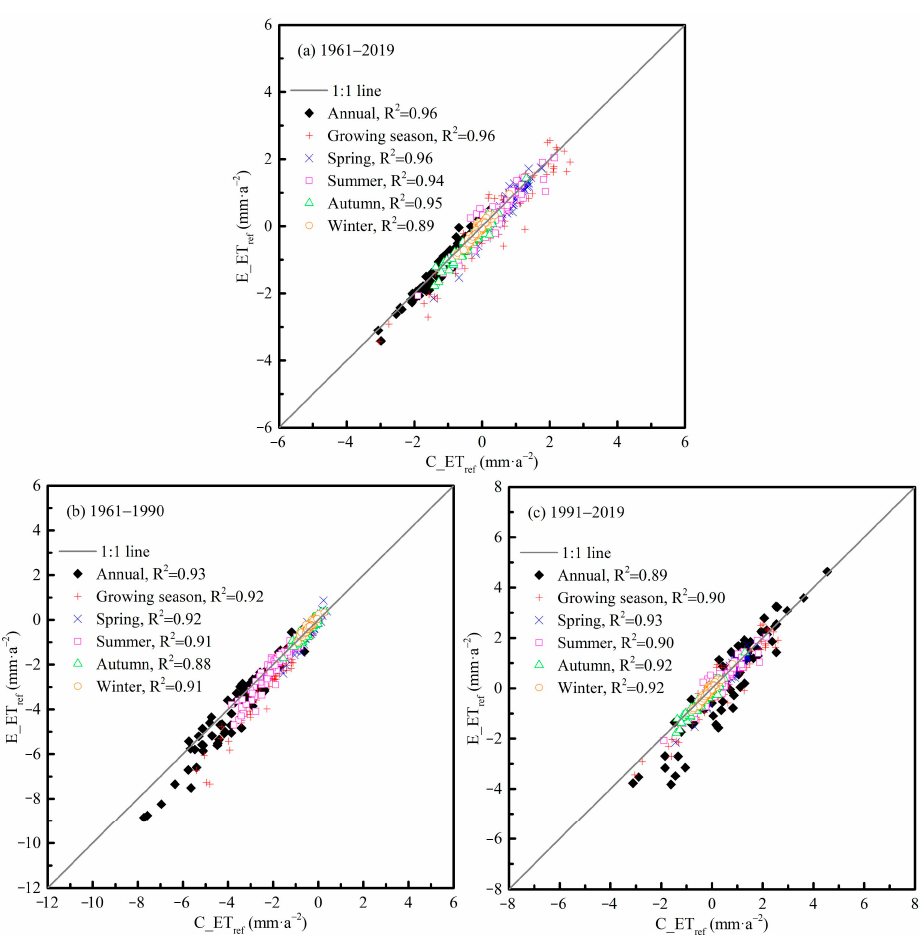
Figure 8. Validation of differential equation method in annual and seasonal timescale during 1961–2019 ( a ), 1961–1990 ( b ) and 1991–2019 ( c ).